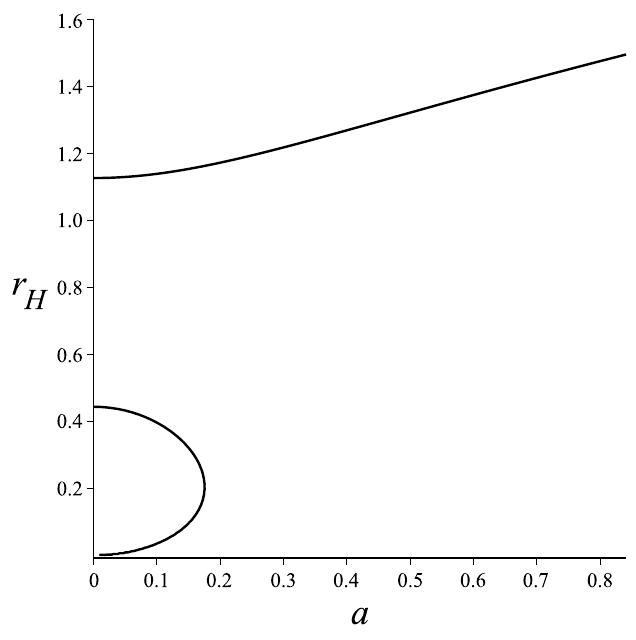
Figure 7 . Radial coordinate at horizon, with L = 1 , T AdSK corresponding to 0